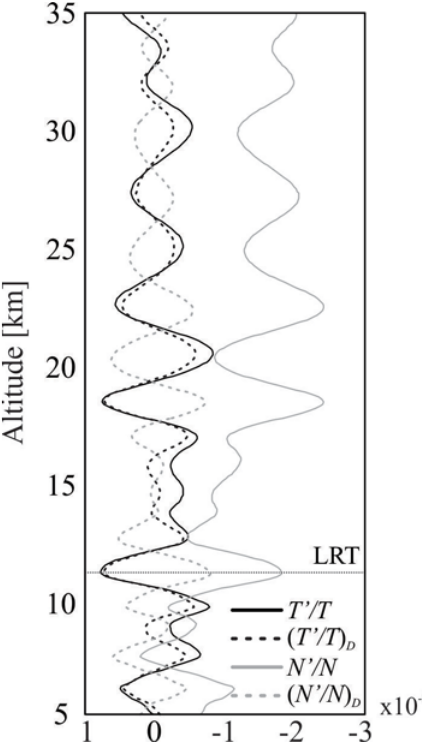
Fig. 6. Same as Fig. 5 for a second GPS RO event (Satellite COS- MIC 1, lon=95.29 ◦ , lat= − 23.02 ◦ , 19 July 2010,